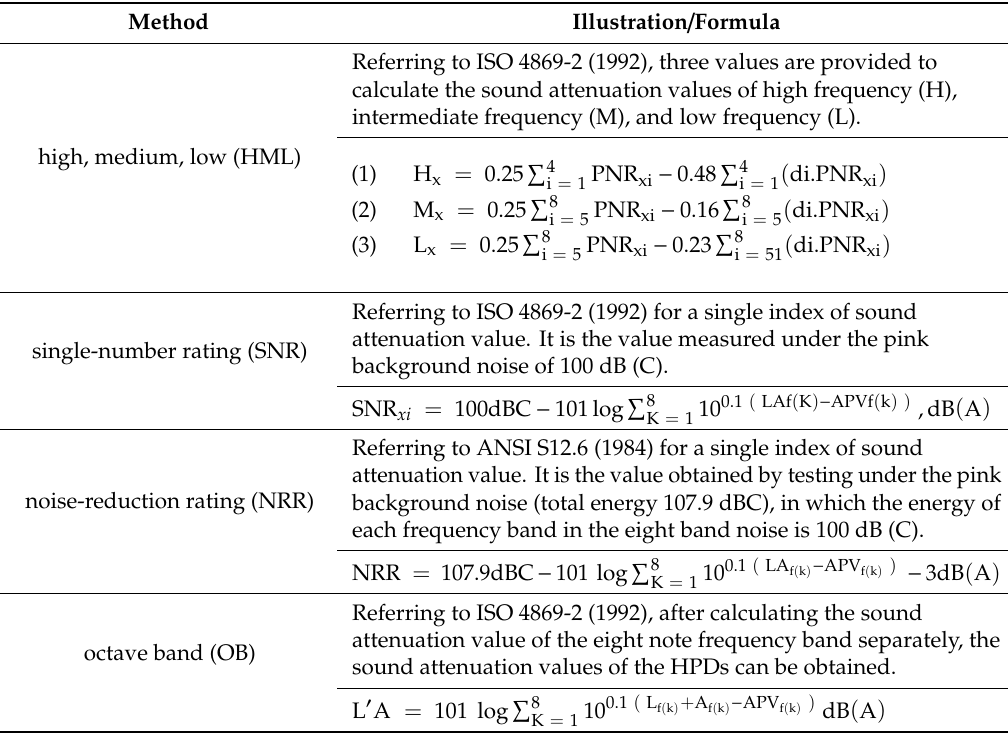
Referring to ISO 4869-2 (1992), after calculating the sound attenuation value of the eight note frequency band separately, the sound attenuation values of the HPDs can be